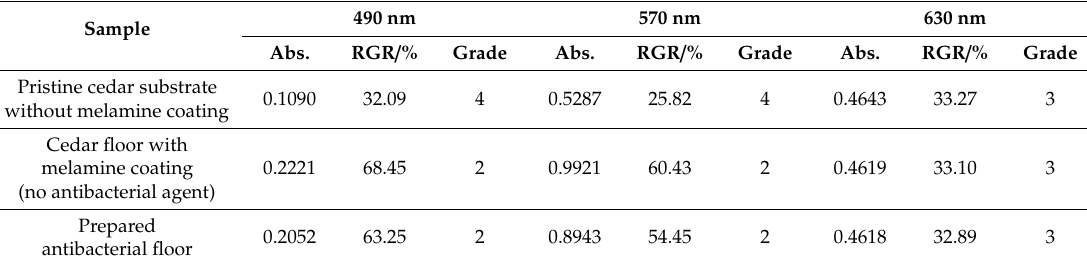
Figure 4. SEM image of cedar parquet floor ( a ) without coating, ( b ) with pure melamine resin solution, ( c ) with Ag-HZDP-loaded melamine resin solution, and ( d ) magnified cedar parquet floor with Ag-HZDP-loaded melamine resin solution. Table 2. Cytotoxic effects of the prepared antibacterial floor .